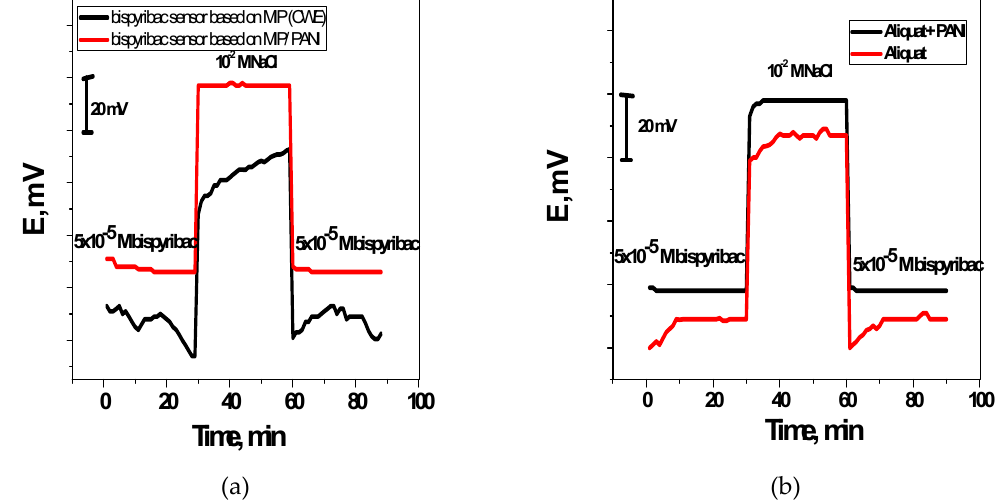
Figure 5. Water-layer tests for the bispyribac-ISE with and without PANI as the solid contact using MIP nano-beads ( a ) and aliquat ( b ) membrane based sensors.